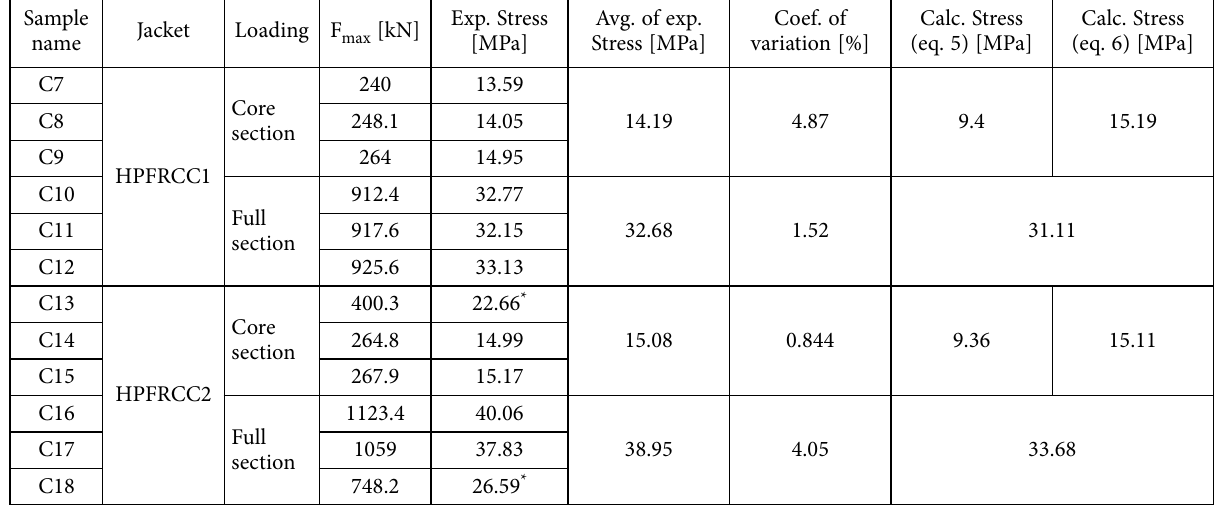
Table 6. Experimental and calculated results of strengthened